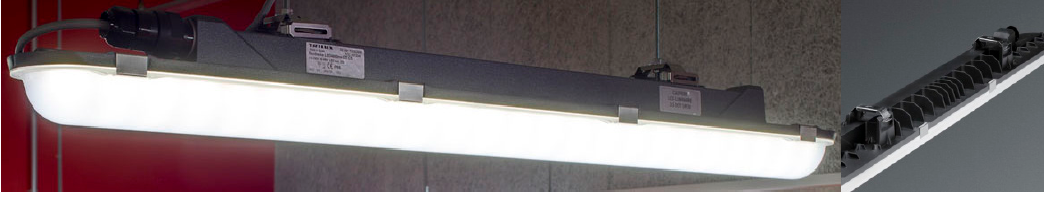
Figure 2. LED luminaire.